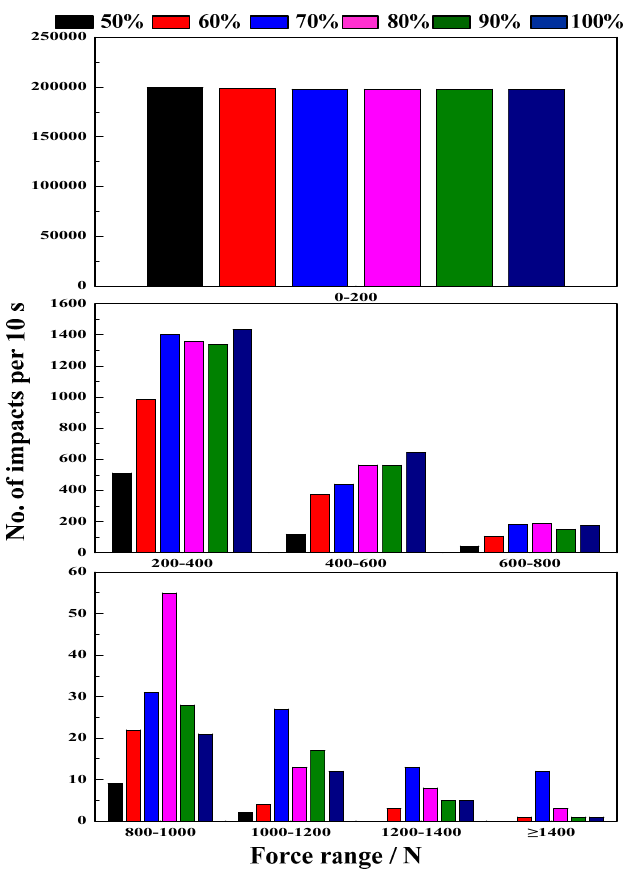
Figure 6. Impact force at different mill speeds.